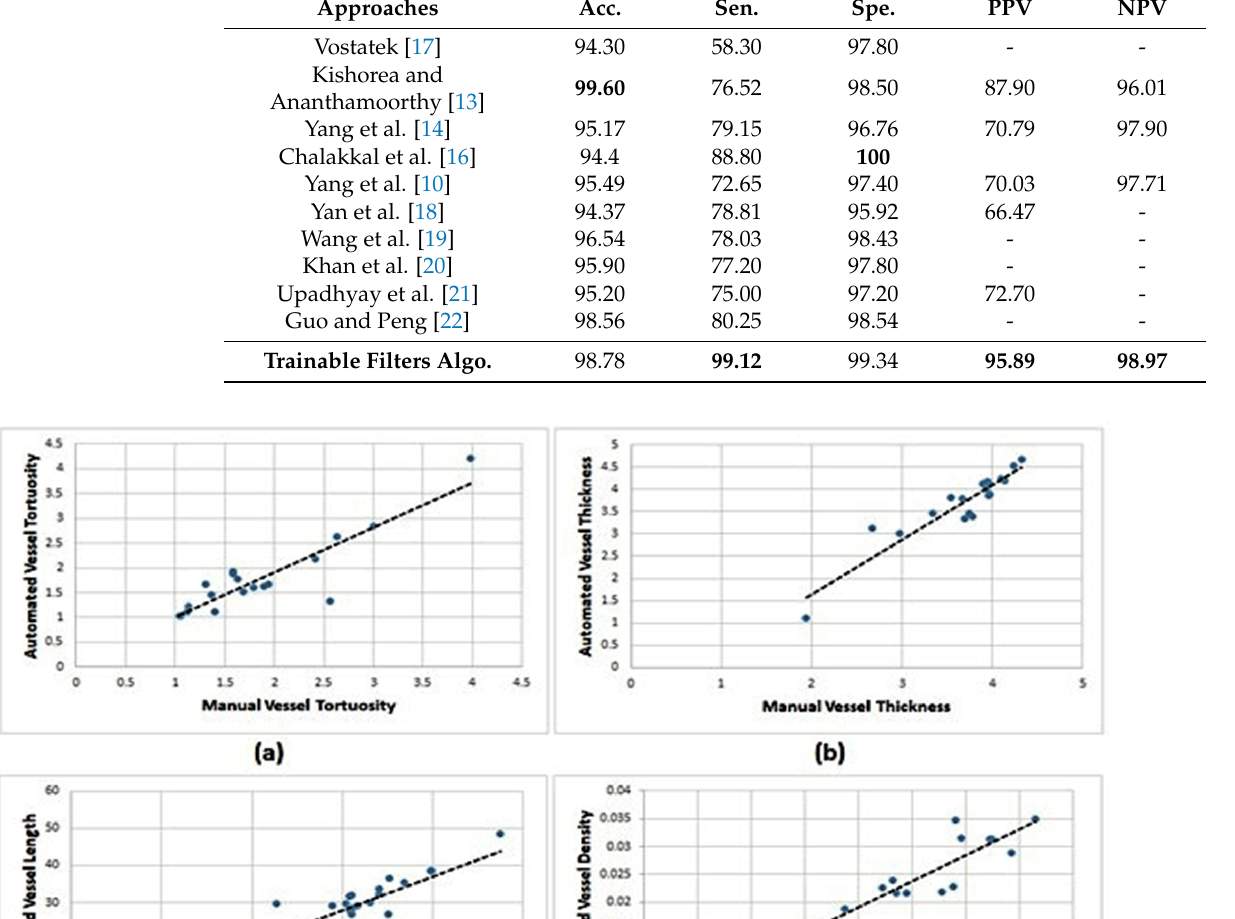
Table 5. Performance comparison of the proposed algorithms with state-of-the-art vessel segmenta- tion approaches on the HRF dataset. Approaches